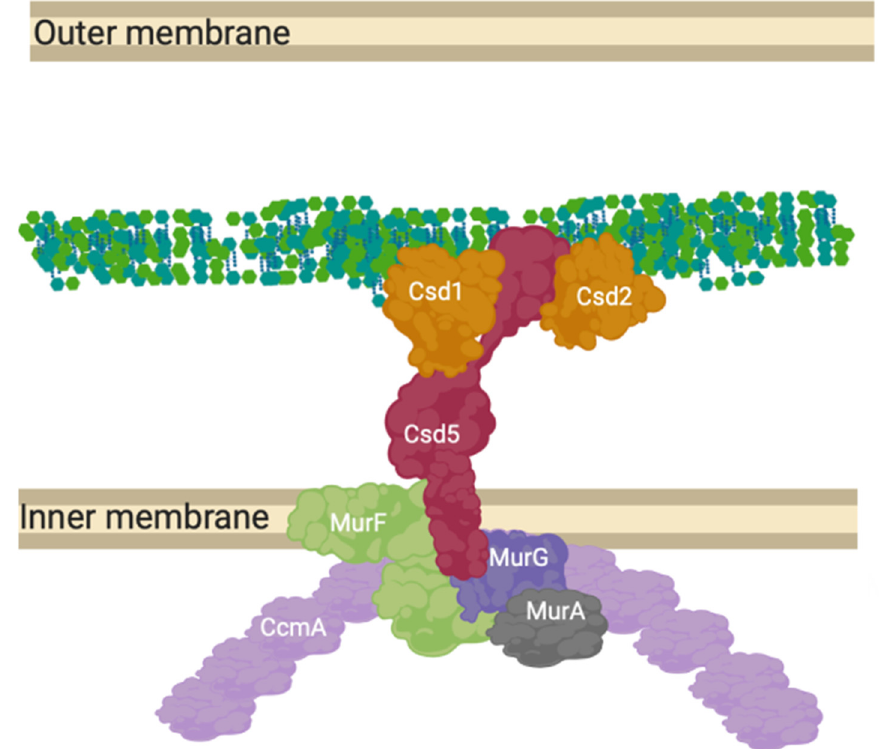
Figure 9. CcmA curvature promoting complex in Helicobacter pylori. The prospective anchored “Shapeosome” of Helicobacter pylori . The Shapeosome is a non-canonical peptidoglycan synthesis complex that facilitates cell shape of curved bacteria, associated with a cytoskeletal component like the elongasome and divisome. The connection to a cytoskeletal component again suggests a convergent and re-occurring model of shape-determining cell wall modification by complex formation. Csd5 binds peptidoglycan by its SH3 domains and interacts with synthesis related proteins MurG, MurA and MurF, as well as hydrolases Csd1 and 2 [18,72].